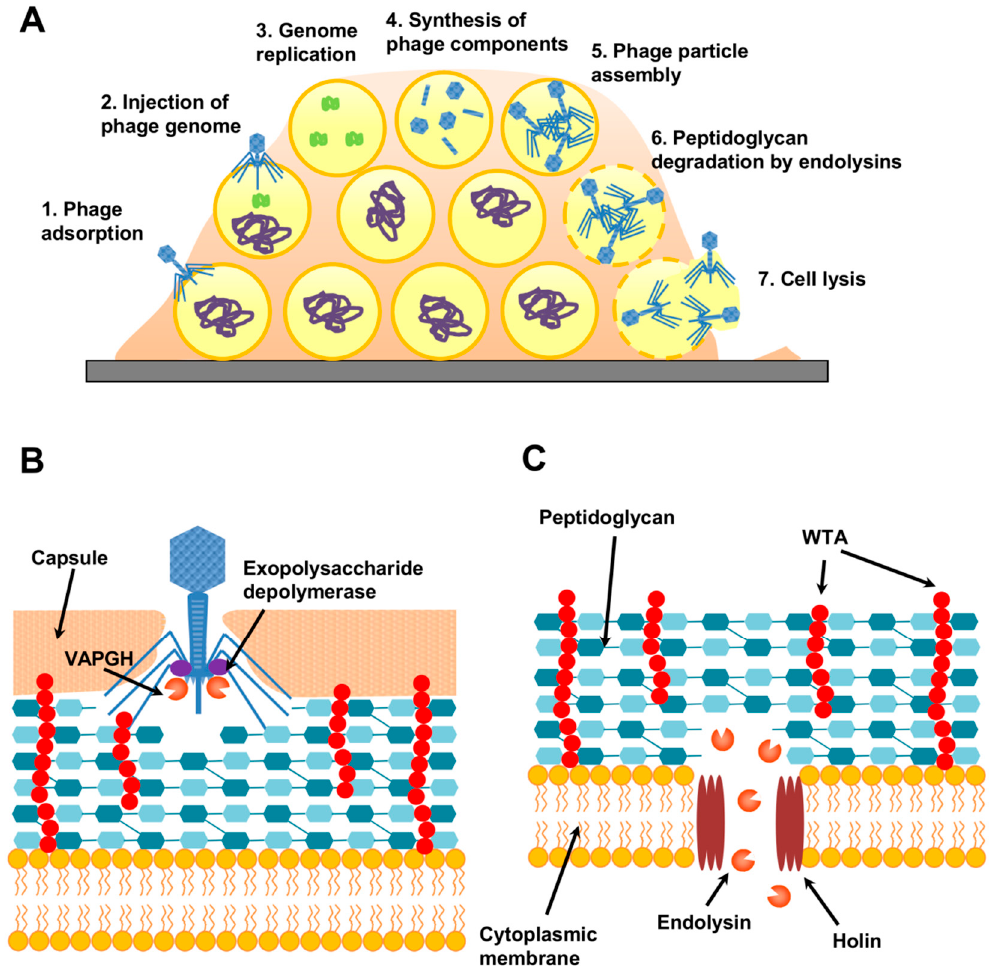
Figure 4. Bacteriophage replication through the lytic cycle. ( A ) Phage-infected S. aureus biofilm in which different cells are undergoing consecutive stages of the lytic cycle, while others remain uninfected. ( B ) Virion-associated proteins with antibiofilm potential that participate in early stages of the lytic cycle (VAPGHs and exopolysaccharide depolymerases). ( C ) Role of endolysins in cell lysis at the end of the lytic cycle. WTA, wall teichoic acids.